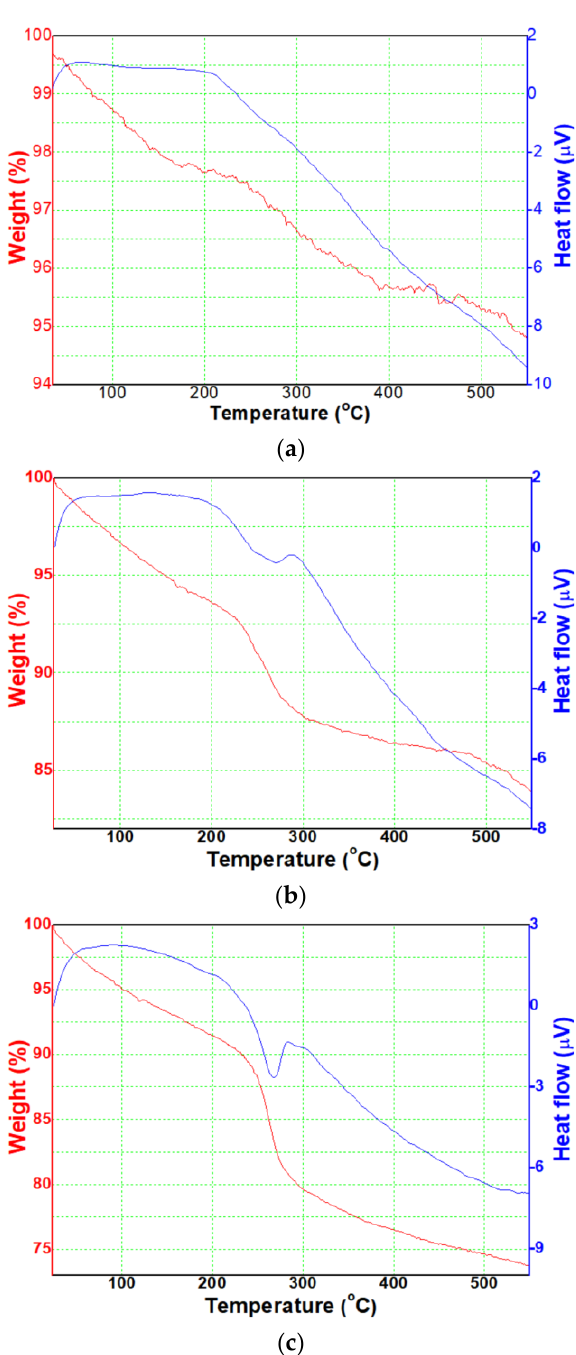
Figure 2. Thermal behaviors of the precipitates with ( a ) 0 wt%; ( b ) 1 wt%; ( c ) 2 wt%.